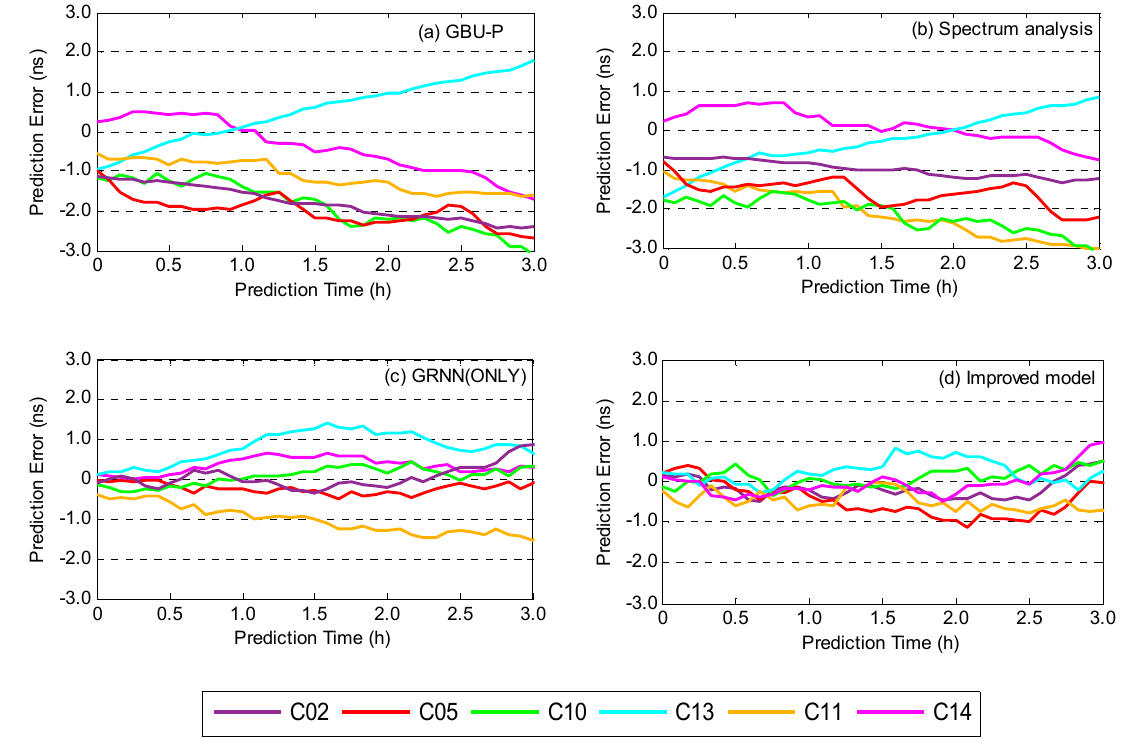
Figure 8. Clock differences between prediction and GFZ precise clock products, using ( a ) GBU-P, ( b ) spectrum analysis model, ( c ) GRNN (ONLY) model and ( d ) improved model.